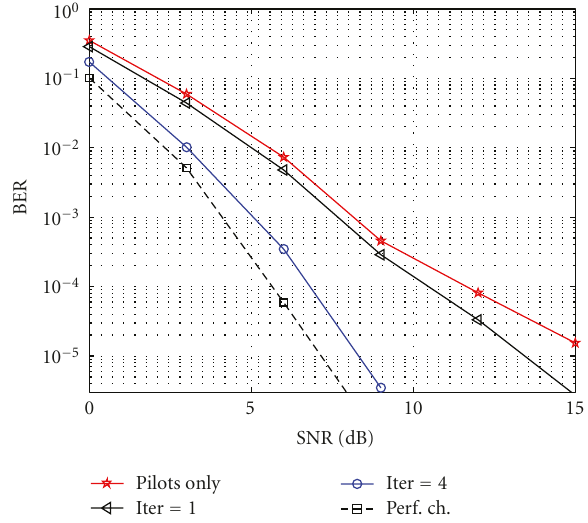
Figure 4: BER performance with di ff erent number of EM